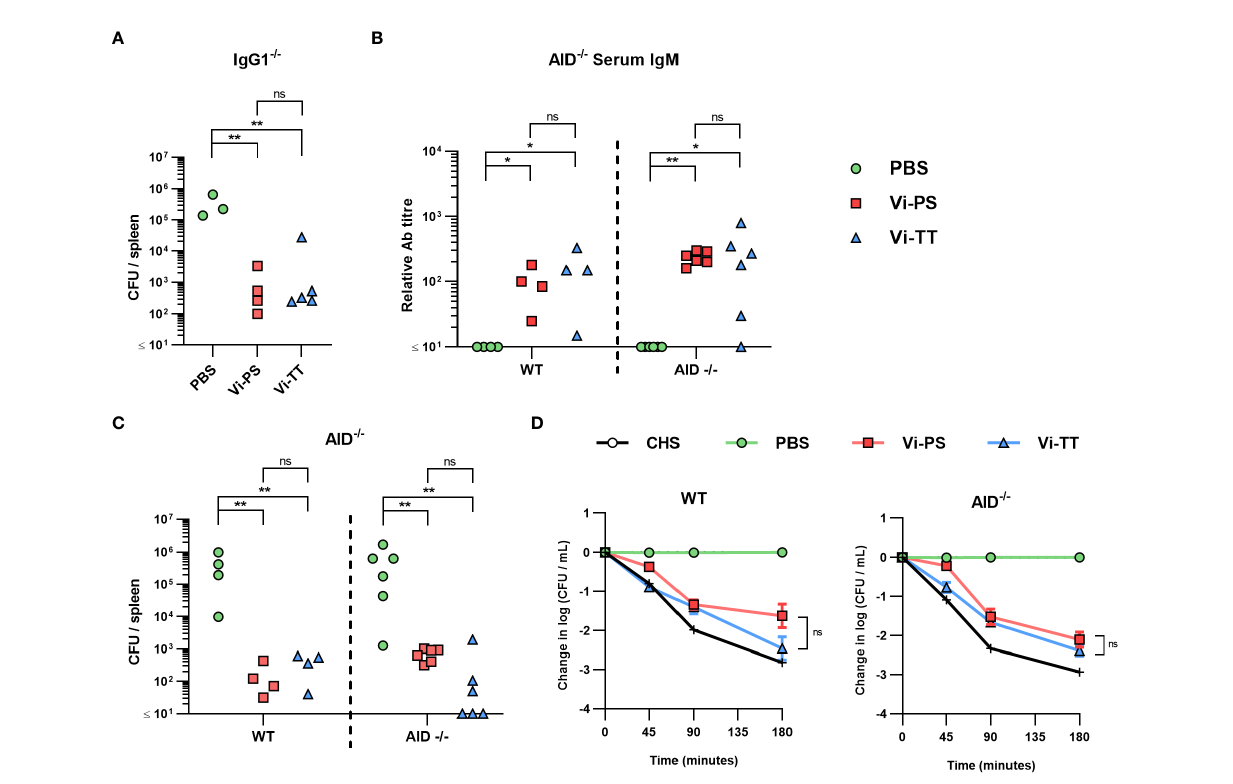
FIGURE 3 Anti-Vi IgM induced by Vi vaccines is suf fi cient to impair infection. (A) Colony forming units (CFU) in the spleen of IgG1 -/- mice immunized i.p with 2 µg Vi-PS, Vi-TT or PBS, then infected for 24 hours with 1x10 5 CFU Vi+ S. Typhimurium TH177 14 days later. Representative of 2 experiments. (B) Serum anti-Vi IgM titres of WT and AID -/- mice after the same challenge schedule were assessed by ELISA after absorption against BSA. (C) Spleen CFU counts of both C57B/6 (WT) and AID -/- mice. (D) Serum bactericidal activity of WT and AID -/- sera was measured against TH177, represented as mean change from the starting LogCFU/mL bacterial dose, normalised to the negative control values at each timepoint. Complete human serum (CHS) was used as a positive control. Error bars represent SEM. Representative of 2 experiments with n = 2-4 mice/group. *p<0.05, **p<0.01, and ns = non-signi fi cant by Mann-Whitney U test between individual groups